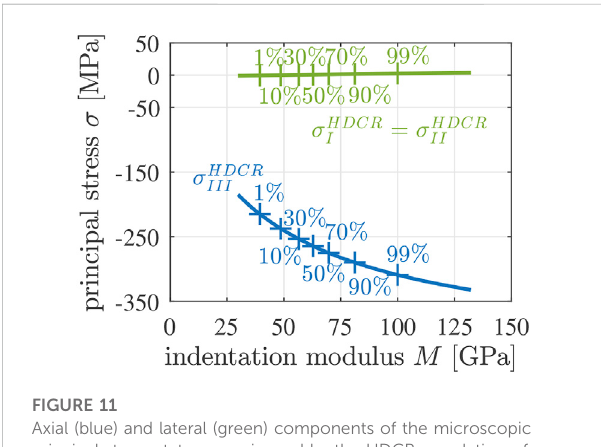
FIGURE 11 Axial (blue) and lateral (green) components of the microscopic principal stress states experienced by the HDCR population of hydrates, as a function of the indentation modulus M ; standard sign convention of continuum mechanics: compression is negative, tension is